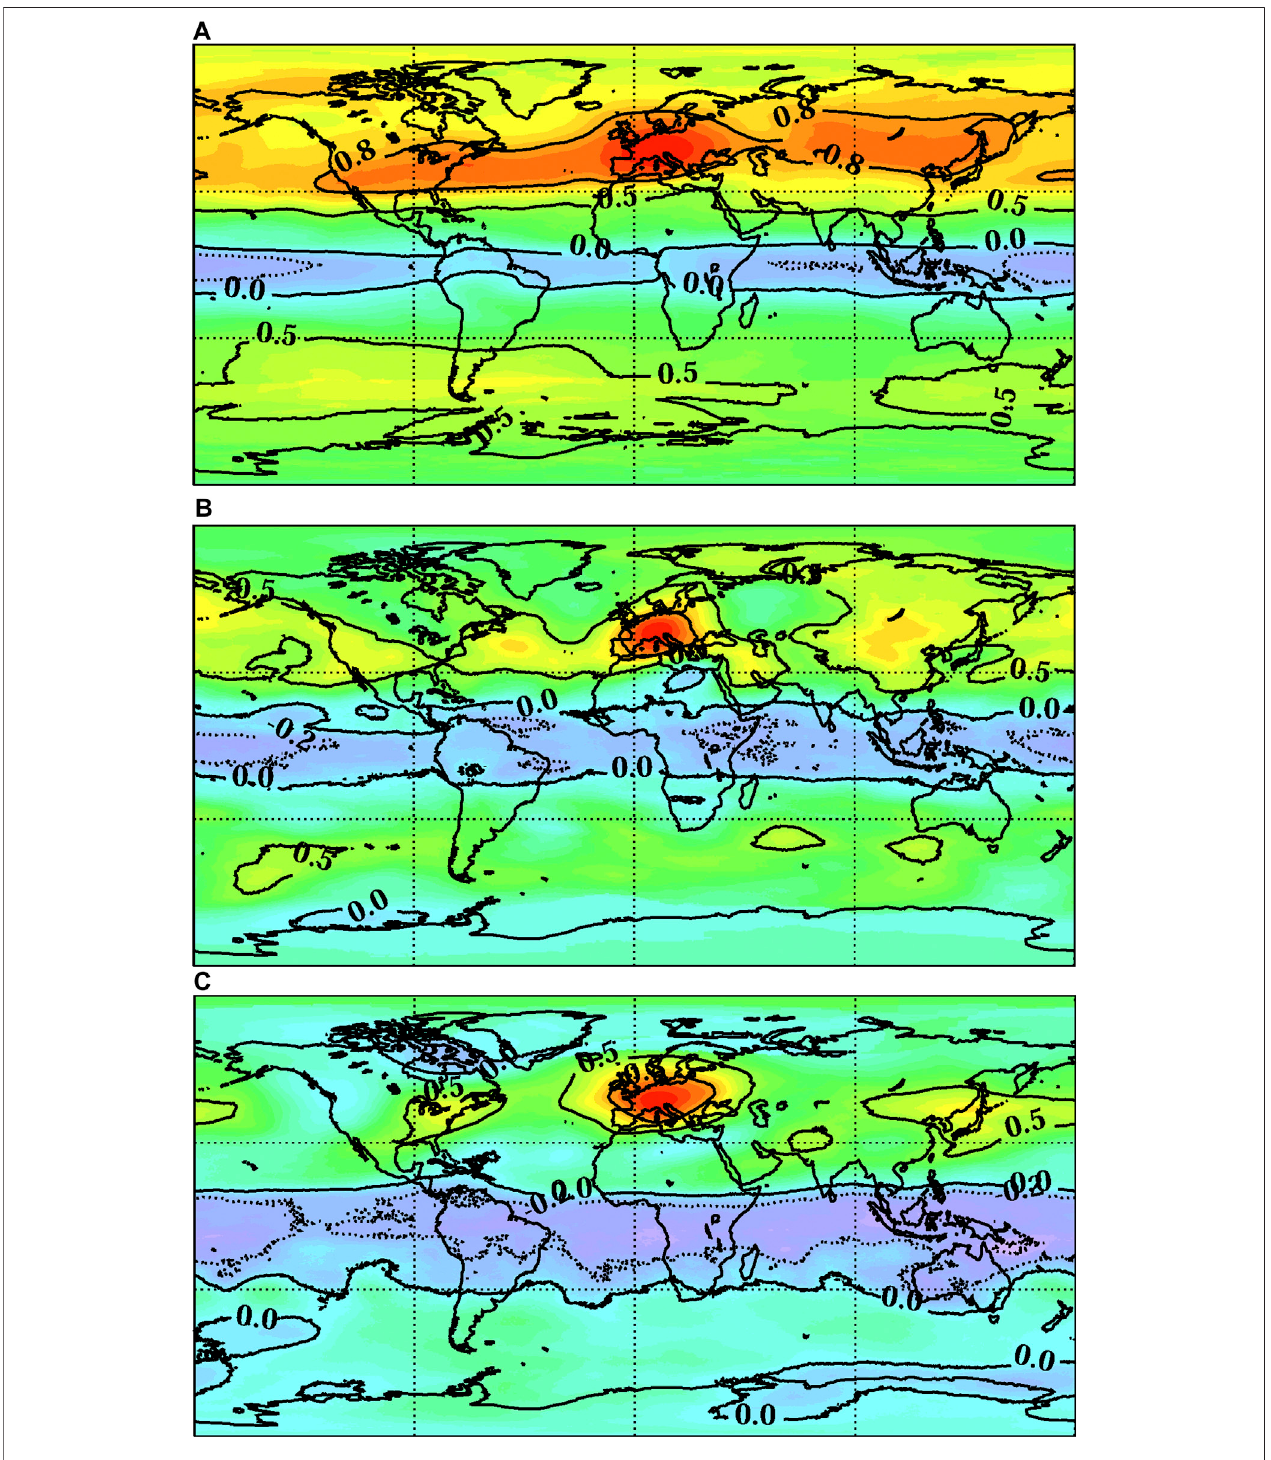
FIGURE 3 | Correlation coefficients between the TCO over Arosa/Davos and other locations for the annual mean (A) , January (B) , and May (C) .